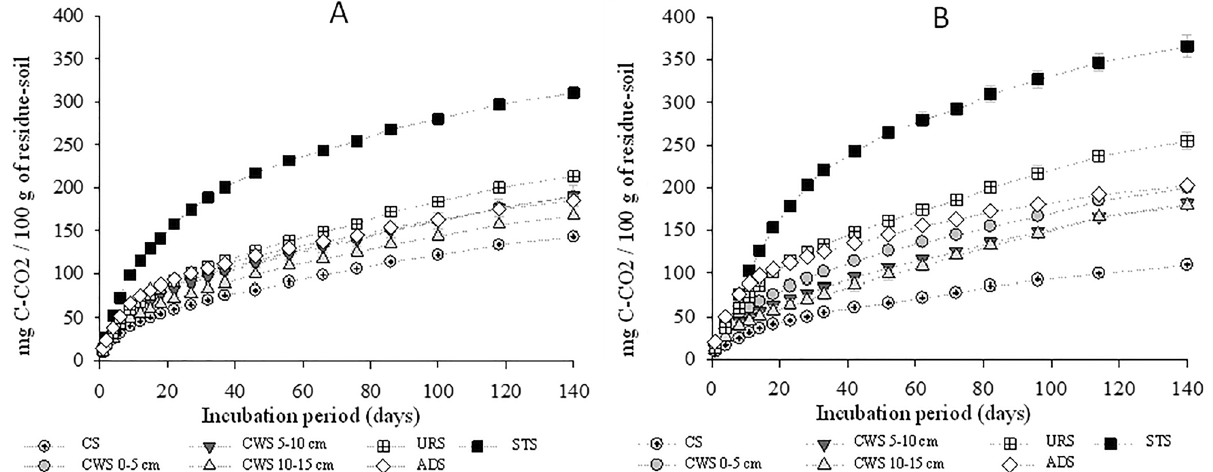
Figure 2. Accumulated quantity of carbon released in the form of CO 2 from soil that was incorporated with the organic residue in dose I of 300 kg ha −1 of N ( A ) and in Dose II of 600 kg ha −1 of N ( B ) and the control soil, during the 140-day incubation